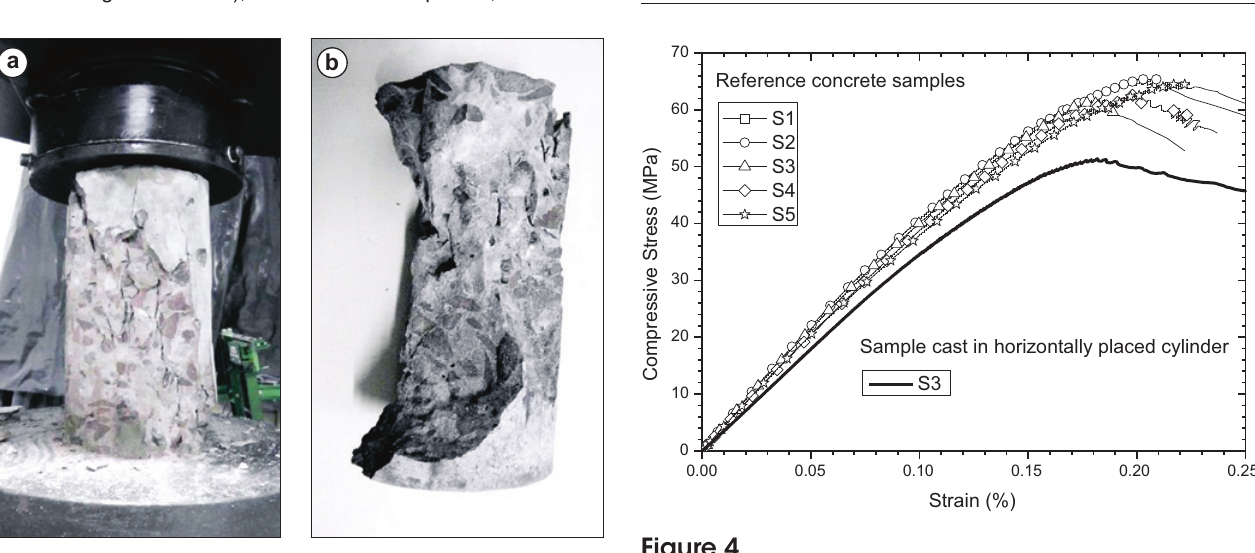
Figure 3 (a) Sample in testing machine showing failure mode, (b) Another sample